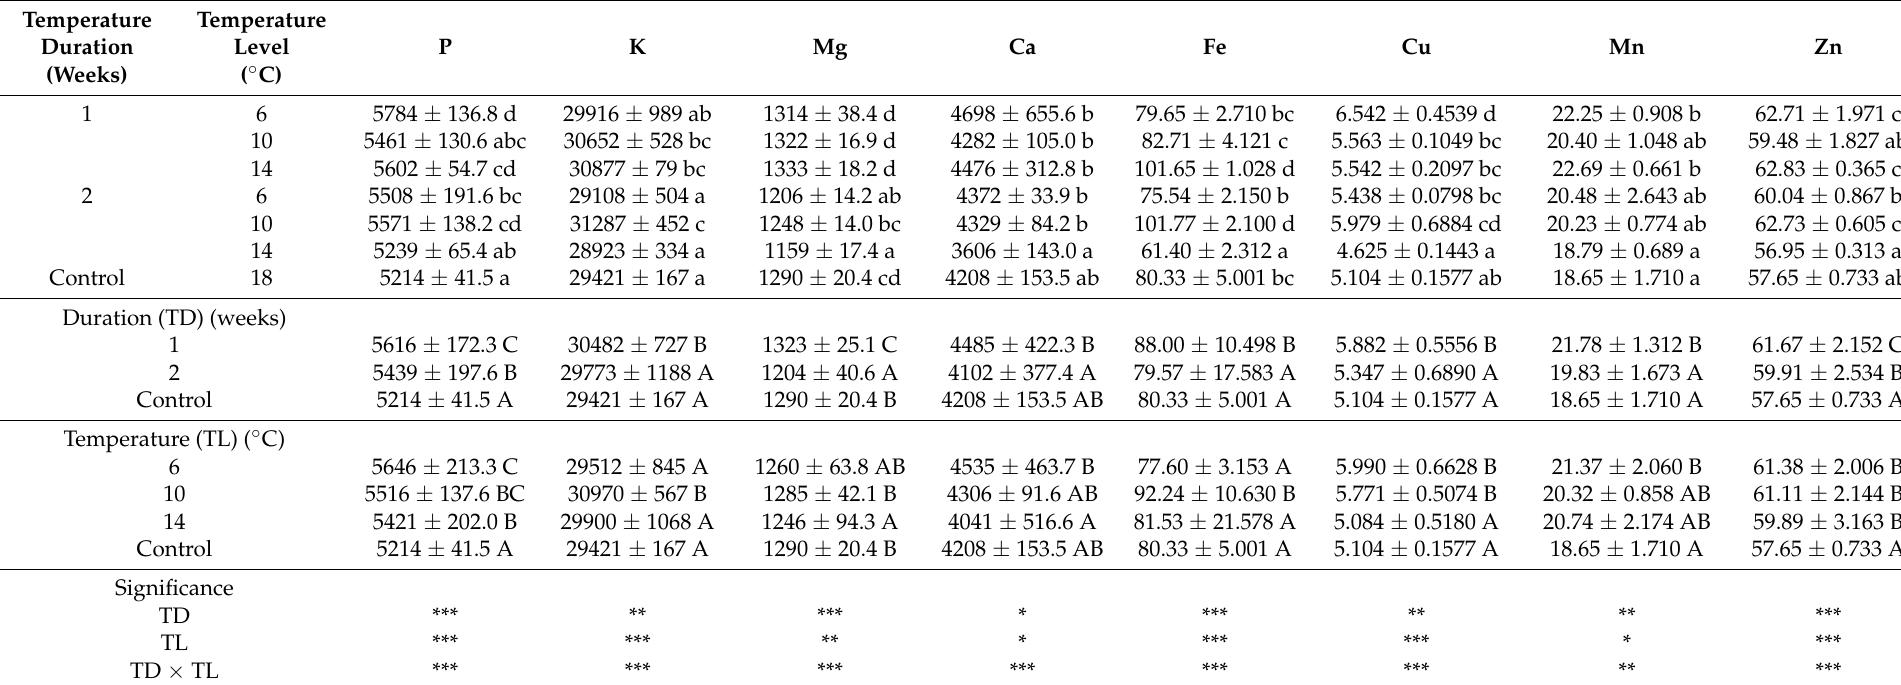
Table 5. Effect of low-temperature treatment of the seedlings on macro- and microelement contents of broccoli heads (mg 1000 g − 1